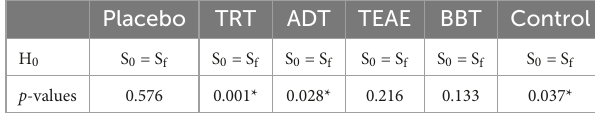
TABLE 5 Statistical comparison between initial session (S 0 ) and final session (S f ) of resulting AUCs of grand average AERPs per acoustic